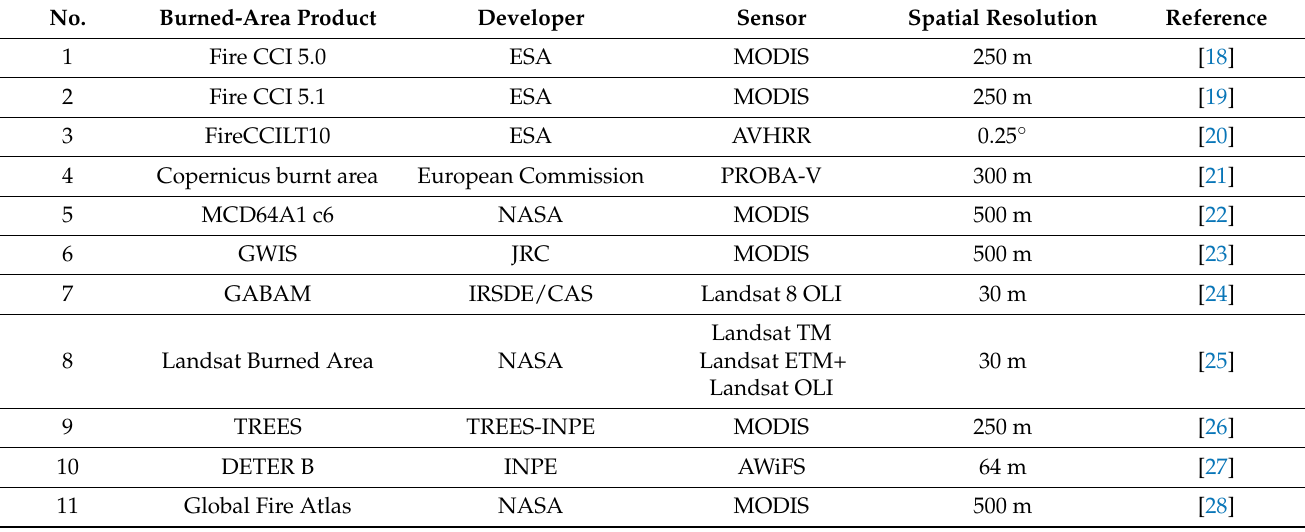
Table 1. Overview of eleven widely used burned-area